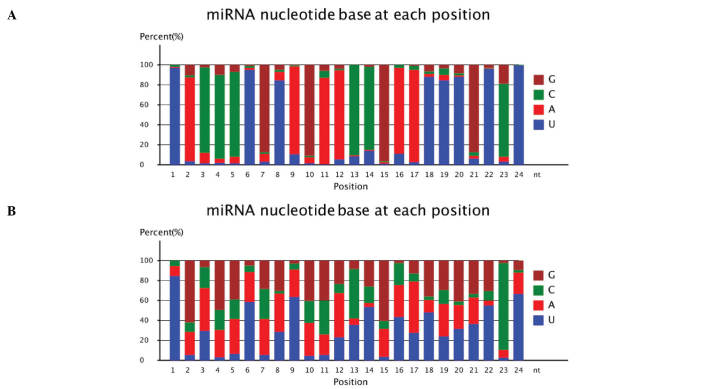
MicroRNA (miRNA) nucleotide base (A/U/C/G) at each position in (A) the membranous nephropathy (MN) and (B) normal control (NC) groups. The percentge of different nucleotide bases at each position. Brown represents G, green represents C, red represents A, blue represents U. A, adenine, U, uracil, C, cytosine, D, guanine.